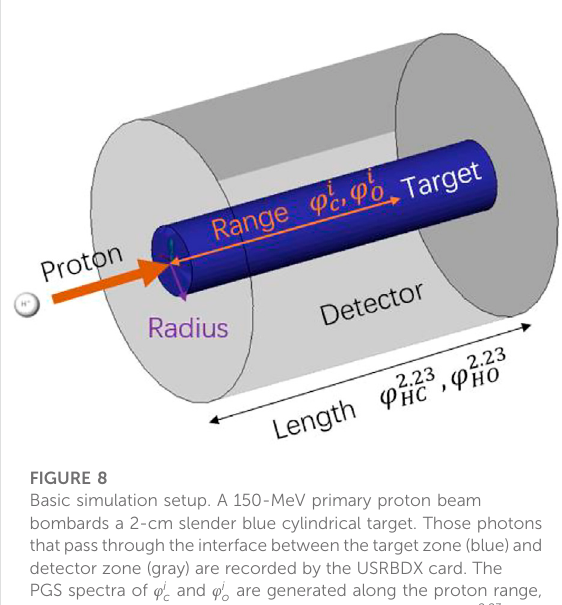
FIGURE 8 Basic simulation setup. A 150-MeV primary proton beam bombards a 2-cm slender blue cylindrical target. Those photons thatpassthroughtheinterfacebetween thetargetzone(blue)and detector zone (gray) are recorded by the USRBDX card. The PGS spectra of φ i c and φ i o are generated along the proton range, where the upper index i is energy. The PGS spectra of φ 2 . 23 HC and φ 2 . 23 HO are generated along the target length as neutrons from the previous reaction still travel beyond the beam